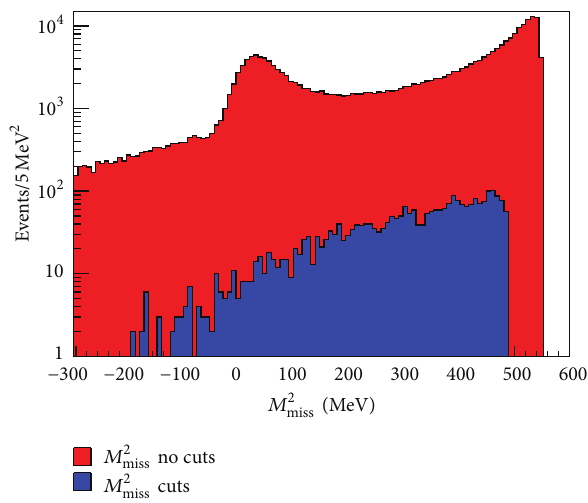
Figure 15: 𝑀 2 for background events: in red with no selection miss cuts; in blue after all cuts